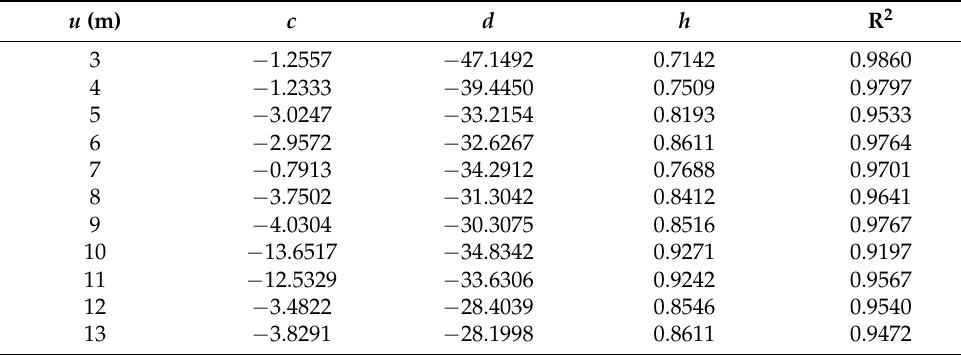
Figure 8. Geometrical properties of intersections for the DFN models shown in Figure 6. ( a ) Fre- quency distributions of intersection lengths; ( b ) Relationship between number of intersections and u; ( c ) Relationship between Li and u; ( d ) Stereonet map of dip directions and dip angles. Table 2. Parameters of fitting curves shown in Figure